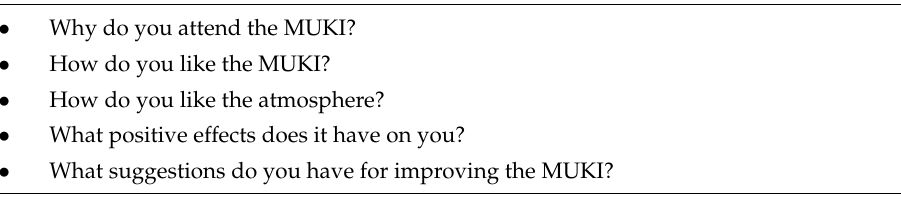
Table A1. Semi-structured interview guidelines for the interviews with female refugees who attended MUKI (N = 16) and with the MUKI’s main staff members ( N = 5). Interview Guide for the Interviews with Female Refugees Attending the